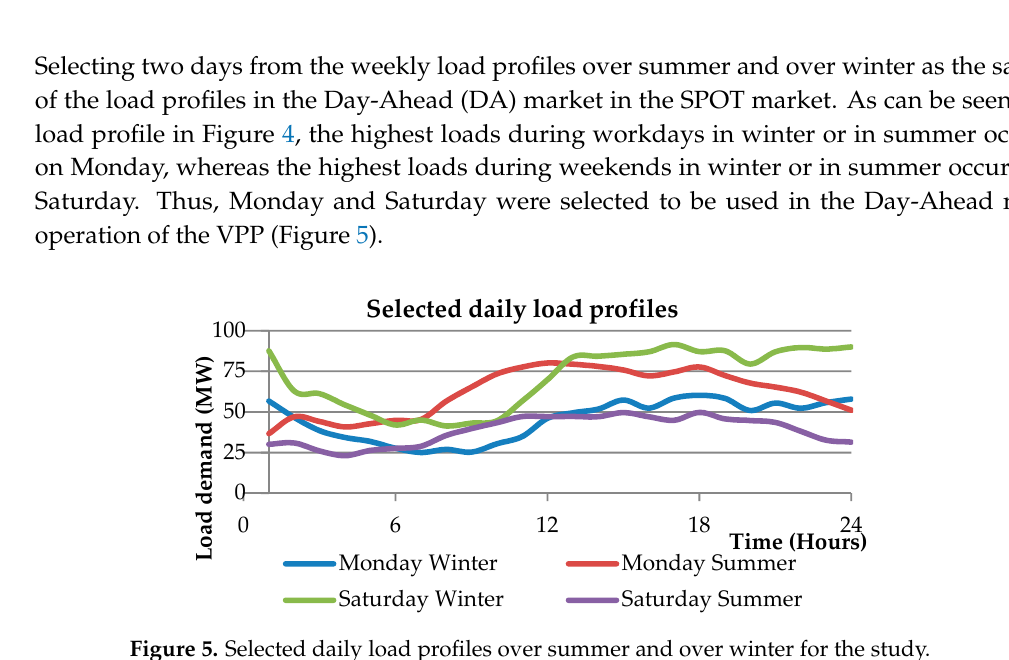
Figure 4. Selected weekly load profiles over summer and over winter for the study.